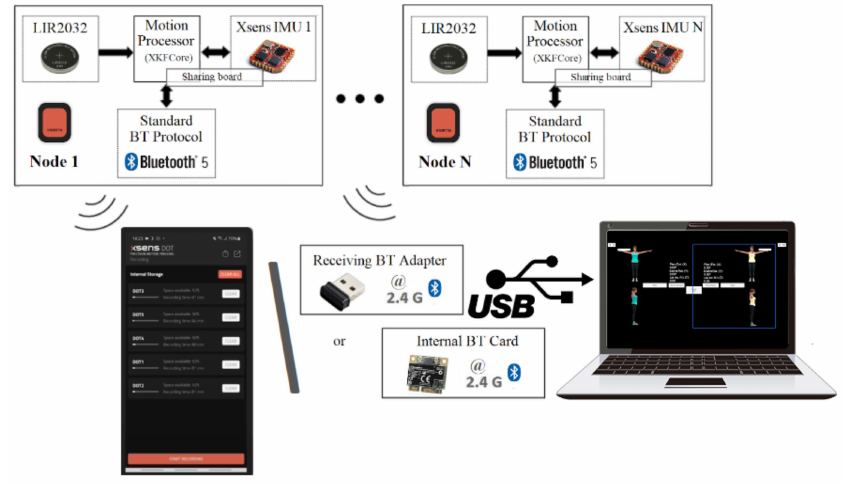
Figure 3. Communication between the Xsens DOT sensors and a BT-capable